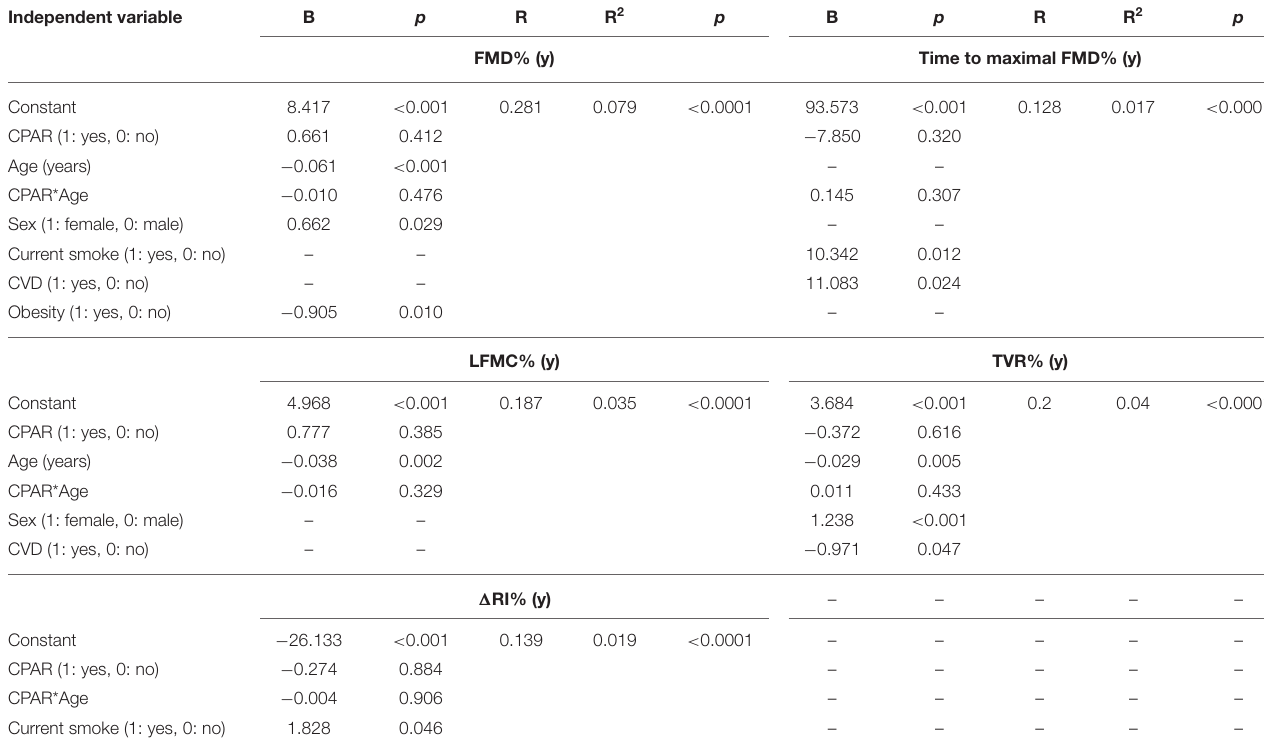
TABLE 8 | Association between CPARs and vascular reactivity indexes, with age as a moderating variable. Independent variable B